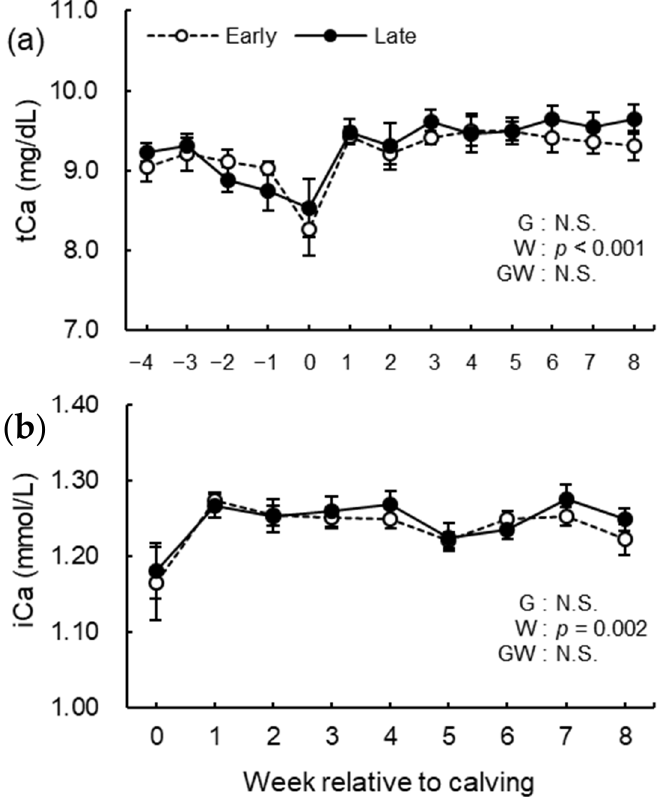
Figure 12. Whole blood concentration of ( a ) total calcium (iCa) from 0 to 8 wk relative to calving and serum concentrations of ( b ) ionized Ca (iCa) from −4 to 8 wk relative to calving for cows classified into the early group (Early) and the late group (Late). Early = cows with endometrial inflammation converged within 4 wk, n = 17; Late = cows with endometrial inflammation converged at or after 5 wk, n = 16. The week of calving is defined as 0 wk. G = group effect; W = week effect; GW = group-by-week interaction. Data are shown as mean ± SEM.